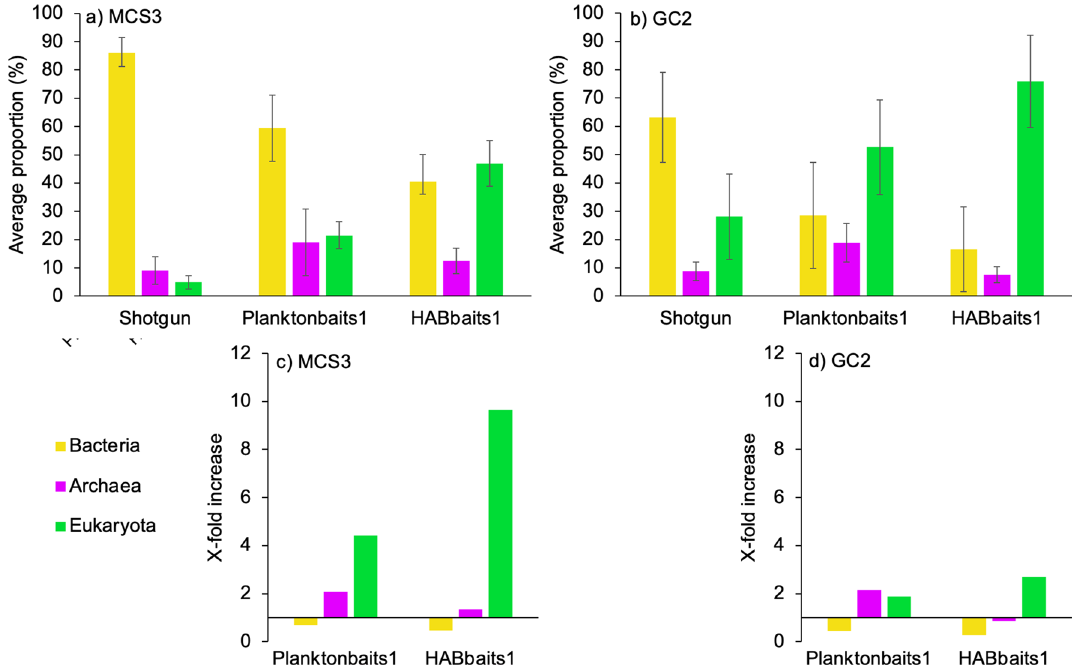
Figure 3. Proportions of reads assigned to Bacteria, Archaea and Eukaryota using Shotgun, Planktonbaits1 and HABbaits1. ( a , b ) Average proportion of reads and standard deviation across inshore MCS3 (n = 9) and offshore GC2 (n = 18) samples, respectively. ( c , d ) Increase in the proportion of Bacteria, Archaea and Eukaryota in Planktonbaits1 and HABbaits1 relative to Shotgun for MCS3 and GC2 samples, respectively, based on average proportions shown in ( a , b